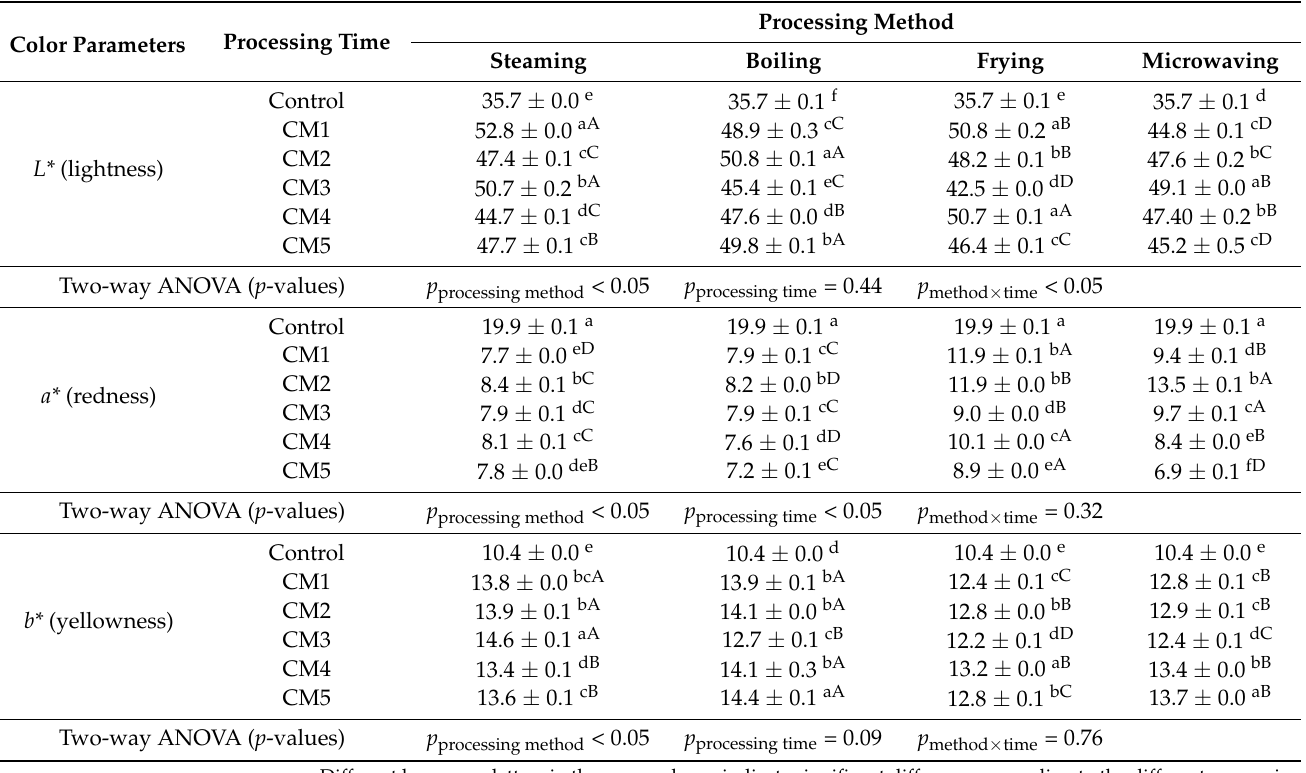
Table 3. Comparison of color difference of camel meat after different heat processing